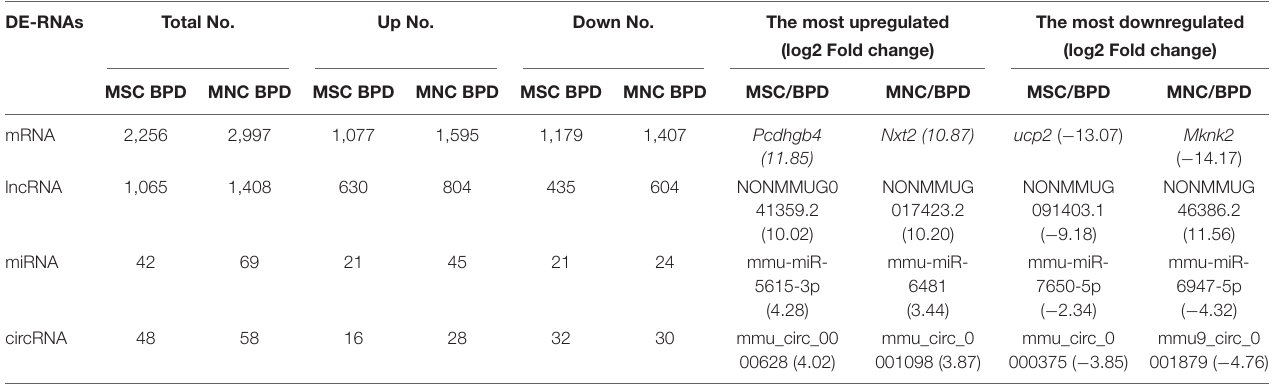
TABLE 2 | Statistical analysis of all of the differently expressed ncRNAs and mRNAs. DE-RNAs Total No. Up No. Down No. The most upregulated The most downregulated